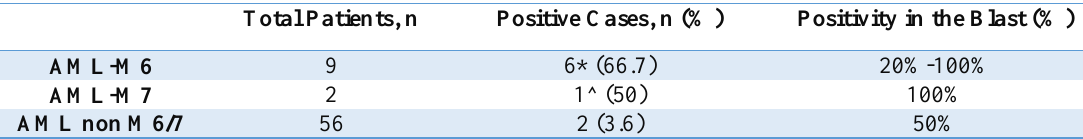
*Positive staining in